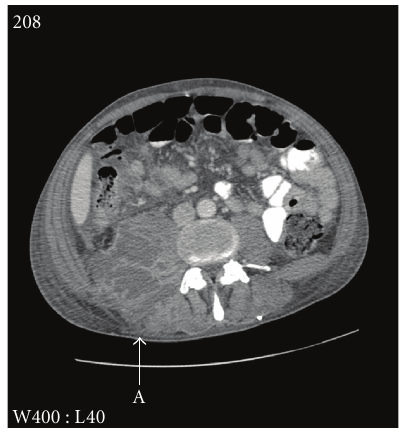
Figure 1: MRI, coronal view. Right-sided psoas abscess (A) with surrounding oedema (B) pushing the right kidney anterolaterally (C).